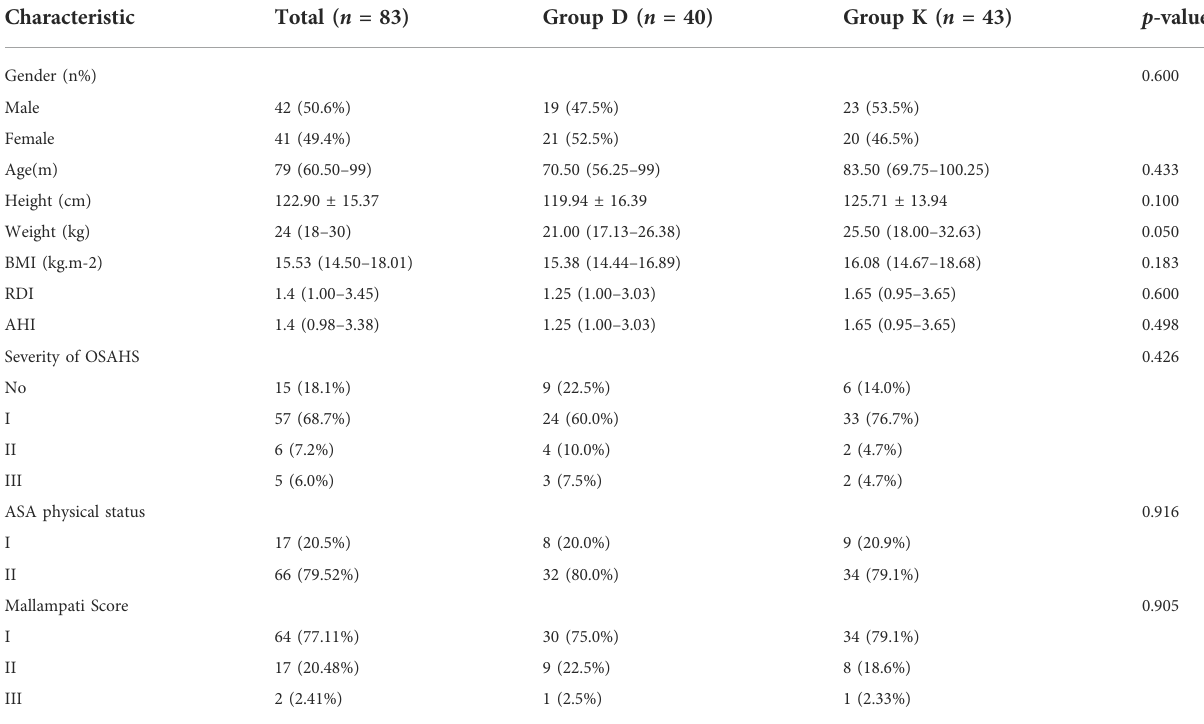
TABLE 1 Demographic and PSG data.